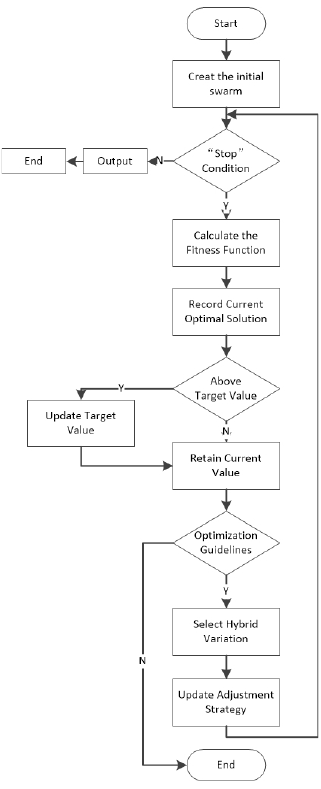
Figure 6. The flow chart of the genetic algorithm.